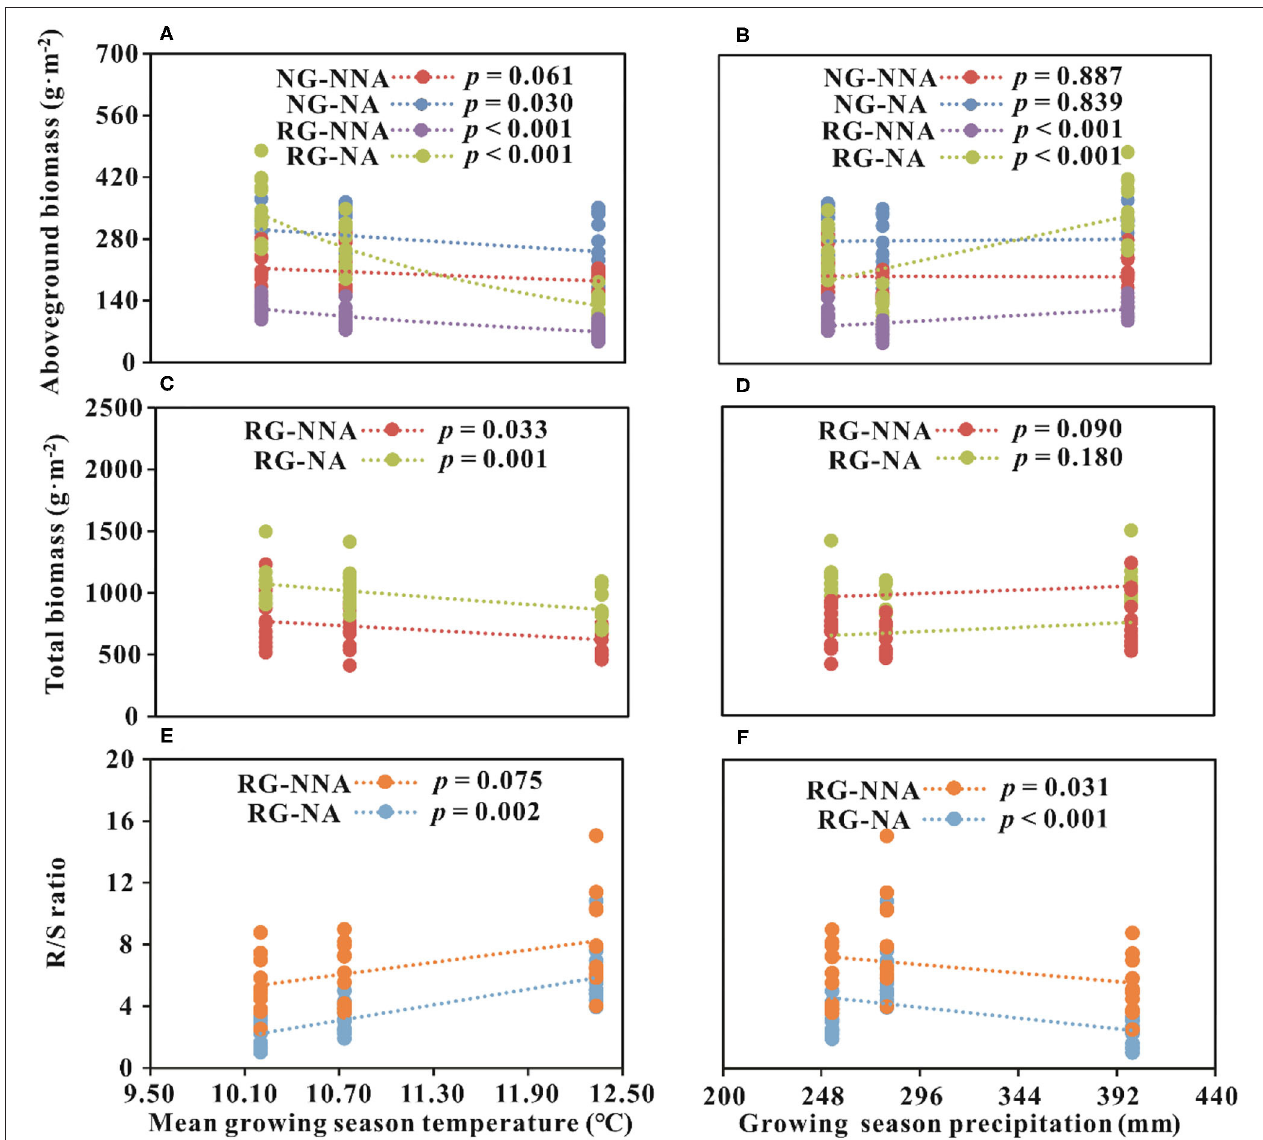
FIGURE 3 | Relationships between biomass parameters and climatic factors. (A,B) Relationships between aboveground biomass and climatic factors; (C,D) Relationships between total biomass and climatic factors; (E,F) Relationships between R/S ratio and climatic factors. R/S ratio, the ratio of root and shoot; NG, natural grassland; RG, restored grassland; NNA, no nitrogen addition; NA, nitrogen